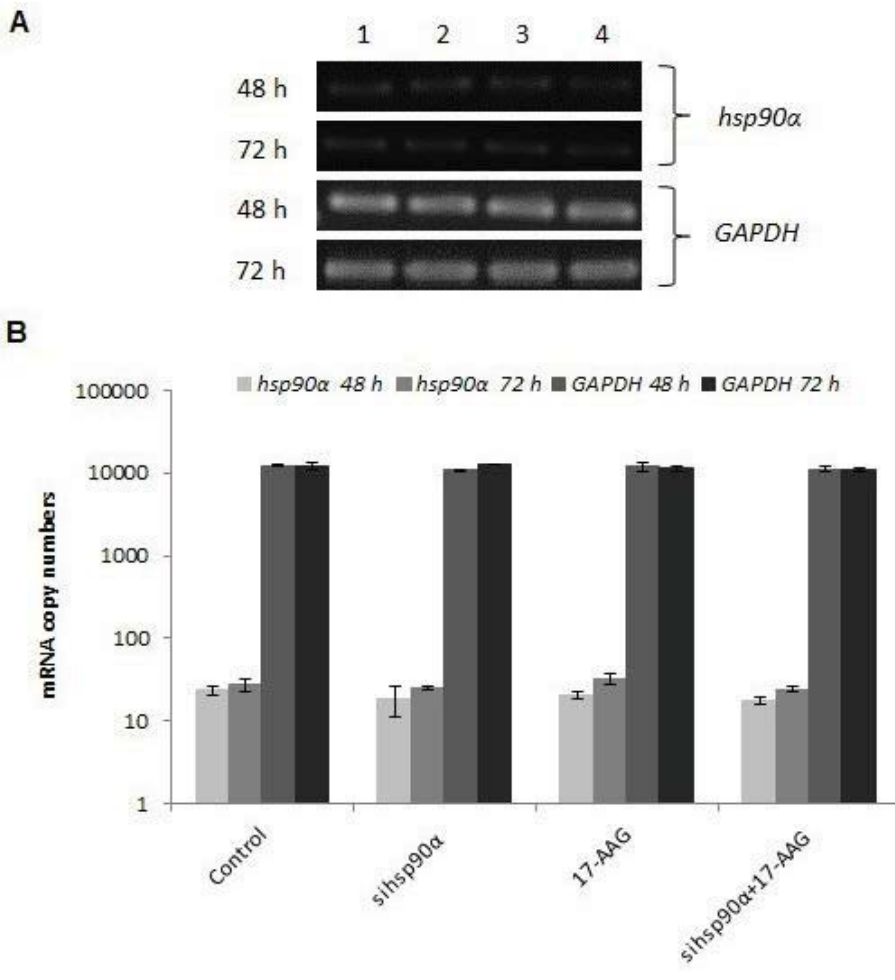
protein levels following sihsp90 (cid:2) and 17-AAG treatment. Figure 4 represents a sample of the stained cells showing a positive staining for Hsp90 (cid:2) . Hsp90 (cid:2) protein levels were significantly reduced following independent treatment with 17-AAG and sihsp90 (cid:2) . Most degradation of Hsp90 (cid:2) protein was observed after combinatorial treatment using 17-AAG and sihsp90 (cid:2) simultaneously, whereby only 4.3% of cells expressed Hsp90 (cid:2) after 48 h and 72 h (Table 2). When used as individual agents, sihsp90 (cid:2) and 17-AAG reduced Hsp90 (cid:2) protein levels to 30.9% and 11.4%, respectively. Based on